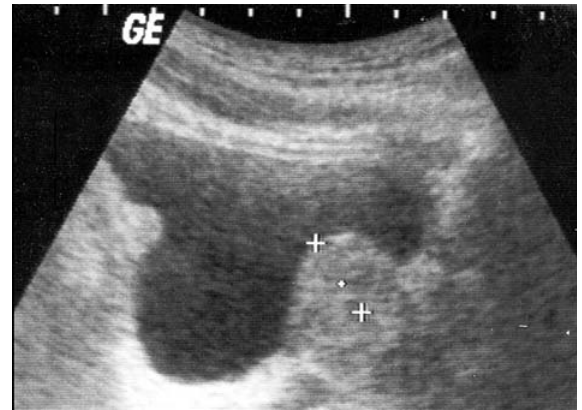
Figure 1 – (cid:54)(cid:68)(cid:74)(cid:76)(cid:87)(cid:87)(cid:68)(cid:79)(cid:3)(cid:89)(cid:76)(cid:72)(cid:90)(cid:86)(cid:3)(cid:82)(cid:73)(cid:3)(cid:69)(cid:79)(cid:68)(cid:71)(cid:71)(cid:72)(cid:85)(cid:3)(cid:68)(cid:81)(cid:71)(cid:3)(cid:83)(cid:85)(cid:82)(cid:86)(cid:87)(cid:68)(cid:87)(cid:72)(cid:3)(cid:88)(cid:86)(cid:76)(cid:81)(cid:74)(cid:3)(cid:87)(cid:85)(cid:68)(cid:81)(cid:86)(cid:68)(cid:69) - dominal ultrasonography. Vertical distance from tip of protru- sion to base of bladder is the intravesical prostatic protrusion